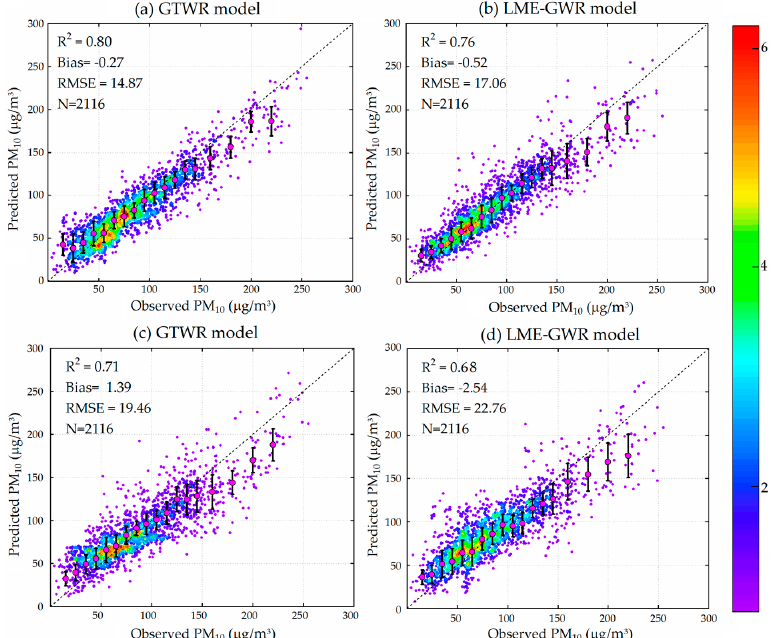
in the upper left corners are coefficient of determination (R 2 ), bias (µg/m 3 ), root mean squared lines on each filled circle represent the 1 σ SD of the fits. Statistical metrics indicated in the upper left prediction error (RMSE, µg/m 3 ) and number of datasets (N). The color bar on the right represents the corners are coe ffi cient of determination (R 2 ), bias ( µ g / m 3 ), root mean squared prediction error (RMSE, number of data pairs. µ g / m 3 ) and number of datasets (N). The color bar on the right represents the number of data pairs.